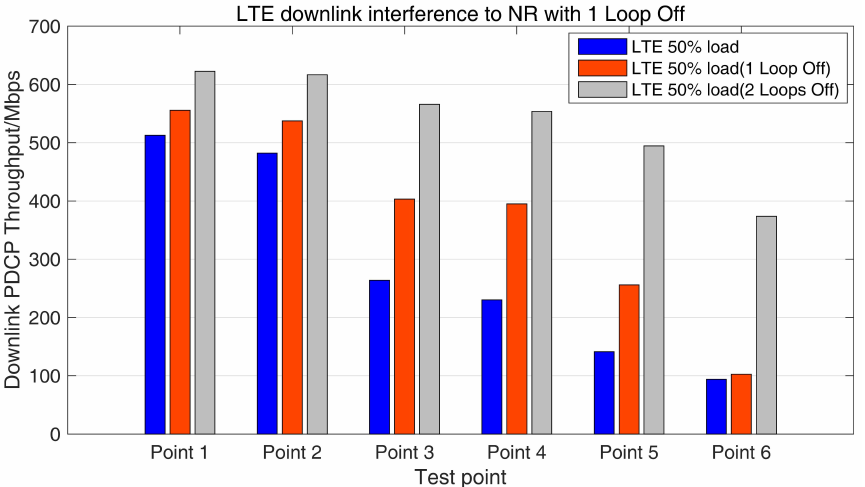
Figure 19. LTE to NR downlink interference test results—buffer setting (50%